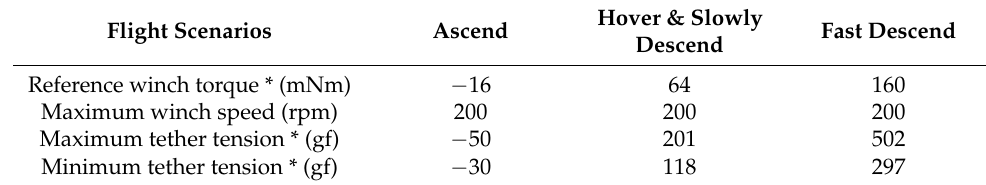
Table A1. Details of winch operation. Flight Scenarios